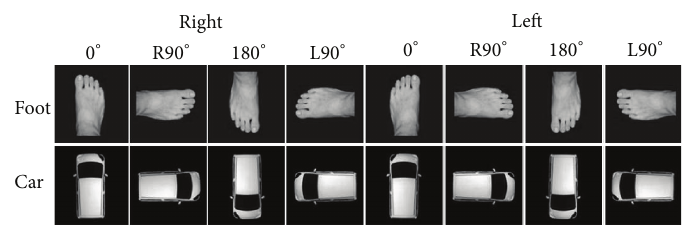
Figure 1: Schematic representation of three visual stimuli (foot and car) at four